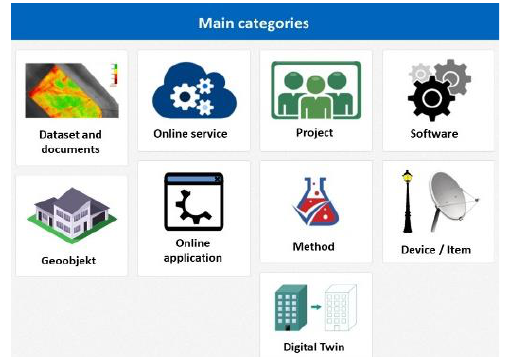
Figure 2: Main categories of information resources